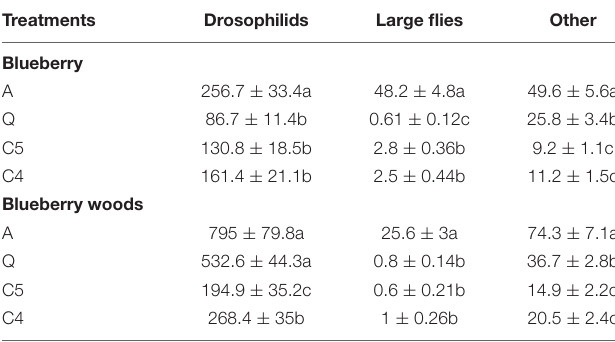
TABLE 1 | Mean ( ± SE) catch (per trap) of non-target: drosophilids, large flies, and other arthropods over the course of trapping in a blueberry field (June 15 to December 19) and nearby wooded area (July 19 to December 19; Maryland) in 2017.